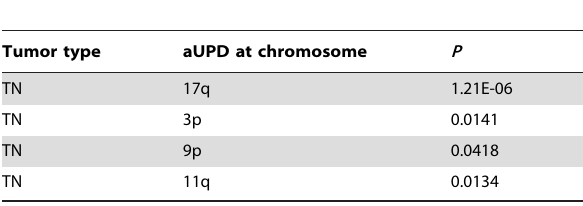
Table 2. aUPD regions as predictors for triple negative breast